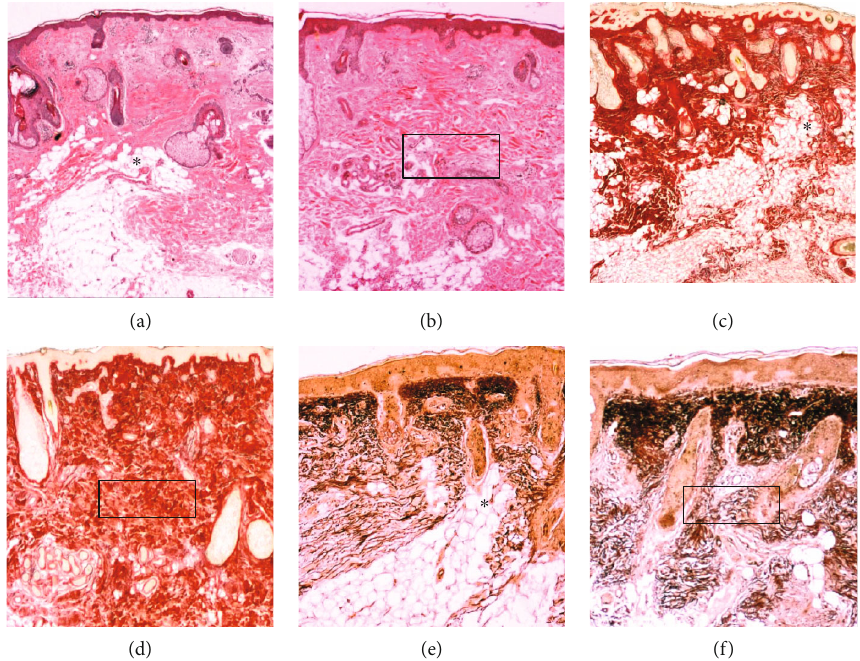
Figure 4: Histological analysis. Skin treatment with PRP: optical microscopy ((a, b) HE stain; (c, d) Picro-Sirius red stain; (e, f) oxidized orcein stain). (a, c, e) Pretreatment and (b, d, f) posttreatment using the PRP biopsies. In the pretreatment specimens, adipocytes are located at the boundary of the dermis with the subcutaneous tissue organized in lobules, which are directed vertically toward the surface of the skin ( ∗ ). These lobules form adipose papillae , which in their apical portion show a relationship with sebaceous or sweat glands. After the use of PRP, fi brosis is apparent through the thickening of the reticular dermis due to elastic fi bers and collagen arranged horizontal and strongly attached (squares).